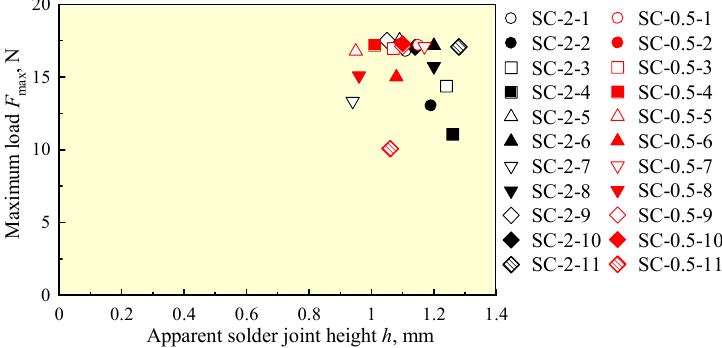
Figure 10. Relationship between the maximum load, F max , and apparent solder joint height, h , for all fast and slow pullout specimens.